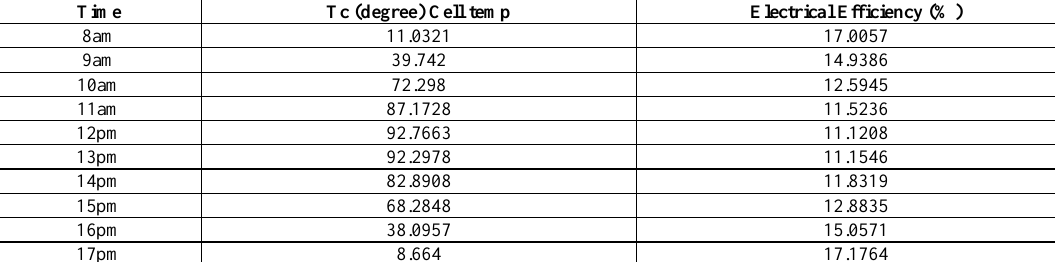
Table 4. Variation of efficiency w.r.t